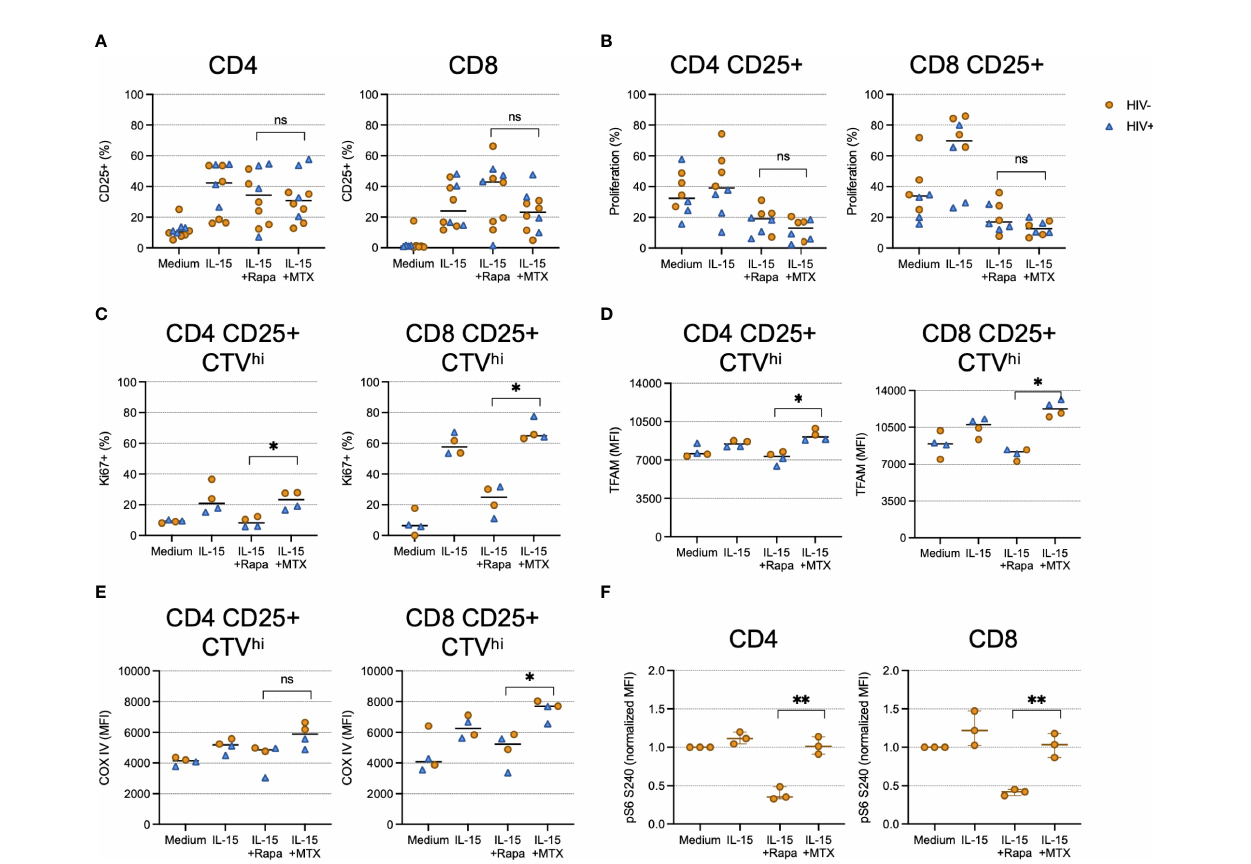
FIGURE 3 | MTXinhibits IL-15-inducedproliferationatastepafter cellcycle entryandmTOR activity. CryopreservedPBMCsfrom PWH(bluetriangles, n=2-4) orHIV-uninfected controls (goldcircles,n=2-6) werelabeledwithCellTraceViolet(CTV) thenstimulatedfor 4days (A – E) or 45 minutes (F) withIL-15(24ngml -1 )inthepresence or absenceofMTX (100nM)or rapamycin(rapa;250ng ml -1 ).Attheendofthe culture,cellswereharvestedandanalyzedby fl ow cytometry. (A) The proportionofCD4(left)andCD8(right) Tcells expressingCD25. (B) TheproportionofCD4 (left) andCD8(right) CD25+cellsthatdilutedCTVdye. (C) TheproportionofCD4(left) andCD8(right)cellsthatdidnotdiluteCTV dye(CTV hi )thatexpressedKi67. (D) Themean fl uorescenceintensity(MFI) ofmitochondrialTFAMamongCD4(left)andCD8 (right) CD25+CTV hi cells. (E) TheMFIof mitochondrialCOXIVamongCD4(left)andCD8 (right) CD25+CTV hi cells. (F) NormalizedMFIofribosomalS6proteinphosphorylatedat S240 amongCD4(left) andCD8(right)T cells.Statisticalsigni fi cancedeterminedbetweenIL-15+rapa andIL-15+MTXgroups;Mann-Whitneytest. ns, notsigni fi cant;*P< 0.05;**P<